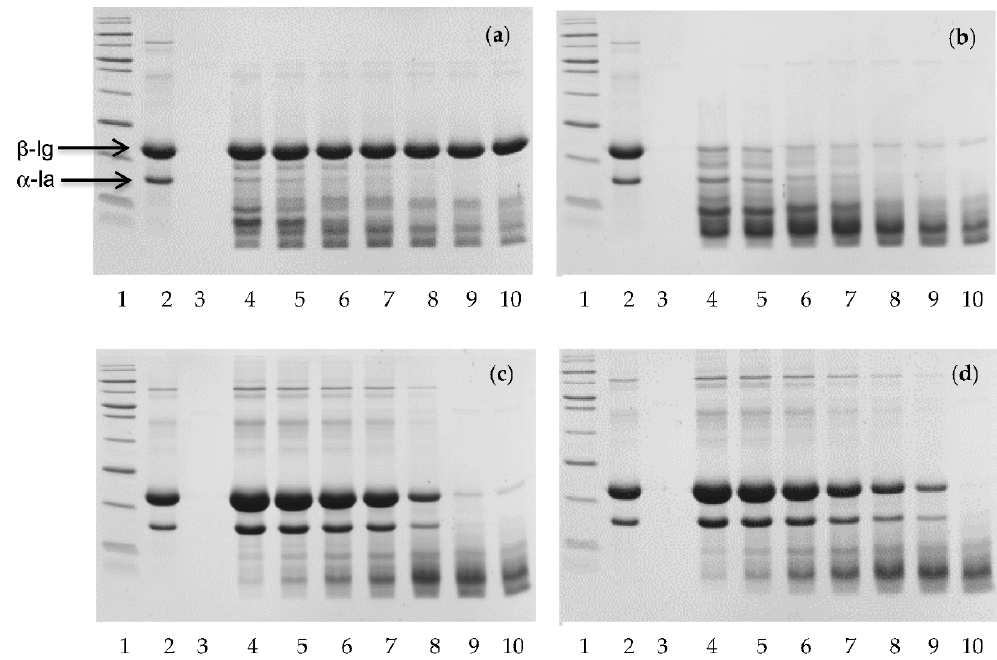
Figure 6. Sodium dodecyl sulfate-polyacrylamide gel electrophoresis (lane 1, maker; lane 2, whey protein isolate (WPI); lane 3, pepsin; lane 4–10, samples being digested for 5, 10, 20, 30, 60, 90, and 120 min) of in vitro digestion of whey protein samples: ( a ) protein liquid at pH 3.0; ( b ) protein liquid at pH 7.0; ( c ) heated protein gel at pH 7.0; ( d ) acid protein gel at pH 5.0.